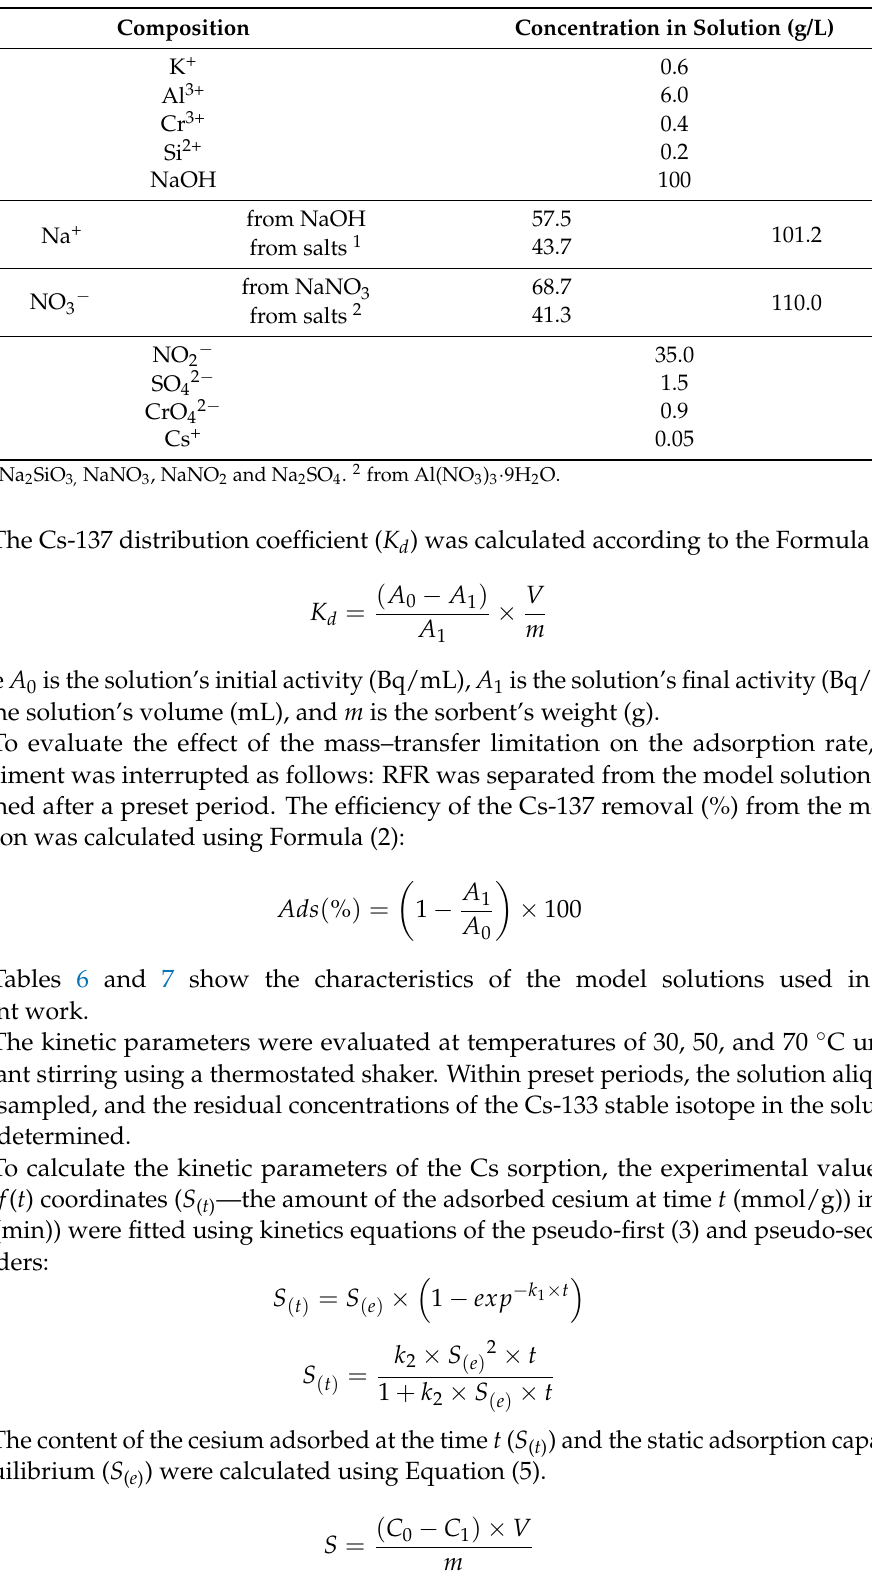
Table 7. Calculated chemical composition of the alkaline model solution simulating the clarified phase in storage tanks with heterogeneous waste of high-level activity, pH ≈ 12 [1], referred as